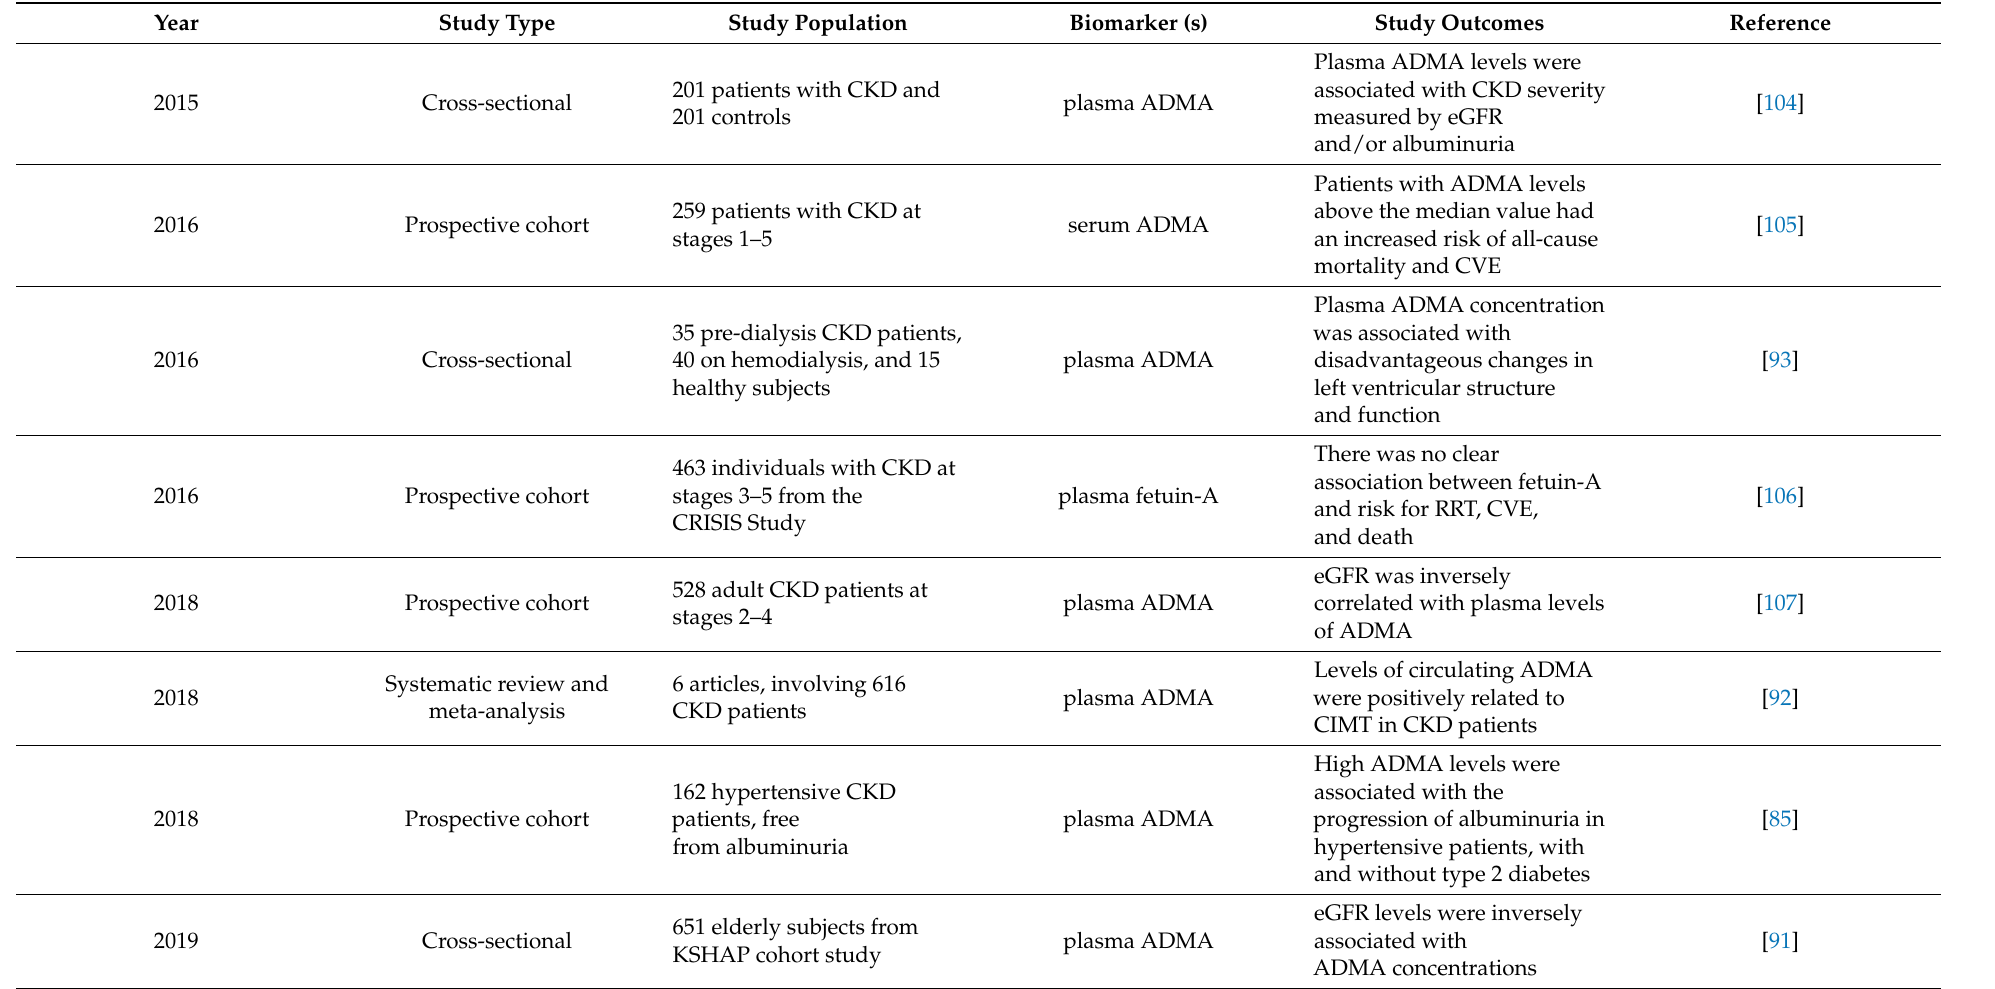
Table 3. Research studies on biomarkers of endothelial dysfunction and main outcomes in CKD